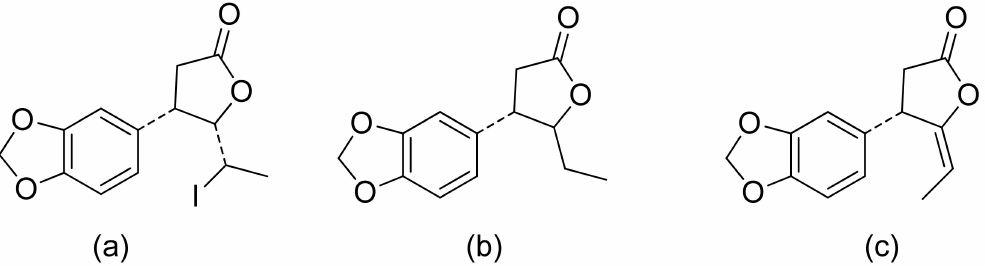
Figure 6. γ -Butyrolactones with a benzodioxol ring at the β -position ( a – c ). Terpenoid constituents from Aglaia forbesii seeds were obtained by the Joycharat group. Isoeichlerialactone, which is a derivative of 3,4-secodammarane, and a second lactone, a derivative of dammaran-3-one (isocabralealactone), were tested against Phytoph- thora botryosa , Phytophthora palmivora , and Rigidoporus microporus . Isoeichlerialactone was active against all phytopathogens tested and showing the best activity against R. micro- porous with a MIC and MFC (minimum fungicidal concentration) value of 62.5 µ g/mL. However, isocabralealactone was active only against R. microporous with MIC and MFC values of 125 and 250 µ g/mL, respectively [23]. Ferna á ndez et al. verified the antifungal activity of lactones derived from Hyalis argentea var. latisquama against Cryptococcus ne- oformans and C. albicans . Lactone derivatives of lindenanolides were the most active. The lowest concentrations that obtained 100% inhibition were 62.5 µ g/mL and 125 µ g/mL, respectively, for one of the lactone derivatives [24]. The antifungal activities of natural and synthetic sesquiterpenoid lactones were tested against phytopathogens by Wedge and colleagues. Two compounds (Figure 7) had significant and moderate activities. One of the compounds (Figure 7b) at a 30 µ M concentration reduced Colletotrichum fragariae growth by 90%, Colletotrichum gloeosporioides by 89%, and Colletotrichum acutatum by 29% but was not active against Botrytis cinerea or F. oxysporum . The other compound (Figure 7a) was the only compound active against B. cinerea with 22% inhibition at a concentration of 30 µ M. It might be concluded that those compounds play a plant defense role in maintaining leaf integrity by inhibiting foliar pathogens